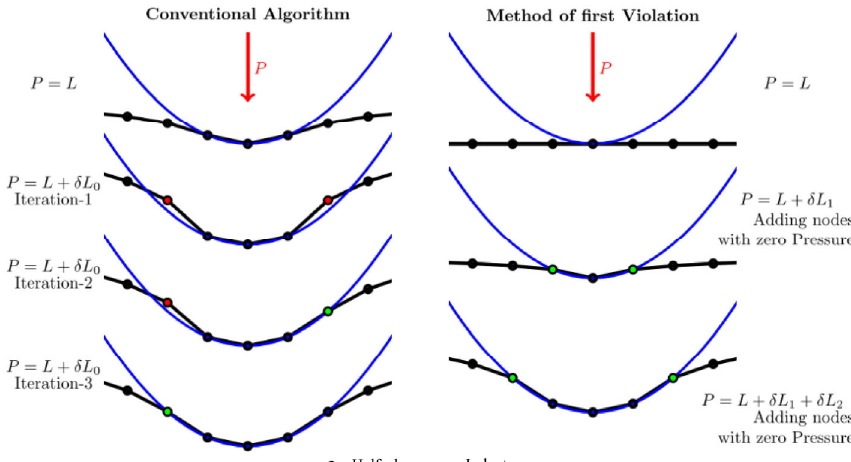
Fig. 60 Difference between the conventional algorithm and method of the first violation. With conventional contact algorithms, a load step is selected and an iterative procedure is used to find an admissible set of loads and displacements consistent with that load step. With the MFV, the load step is computed to be exactly that necessary to bring the first node to change status (contact, non-contact, stick, and slip). Reproduced with permission from Ref. [880], © Elsevier Ltd., 2021.